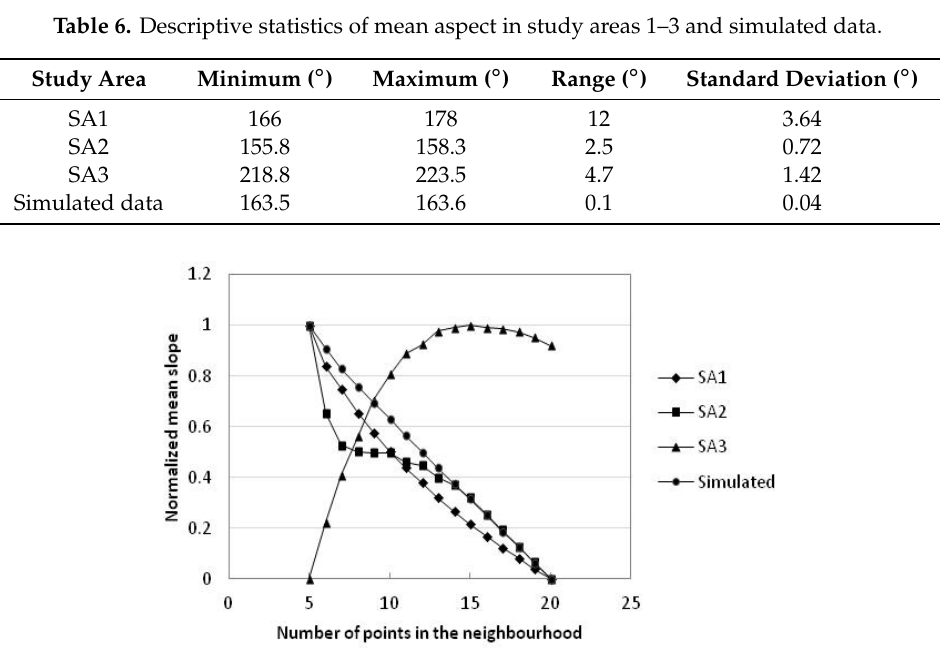
Table 5. Descriptive statistics of mean slope in study areas 1–3 and simulated data.